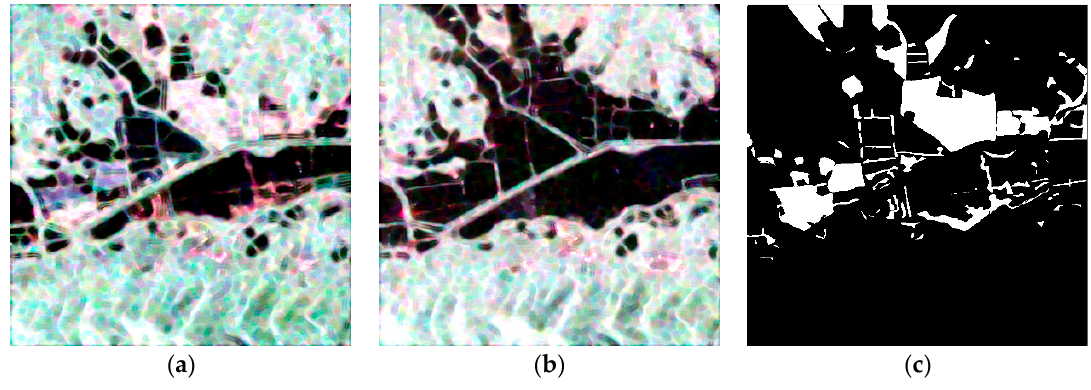
Figure 5. The Pauli-RGB images of YanDong Lake after preprocessing on ( a ) 25 June 2015; and ( b ) 6 July 2016. ( c ) Ground reference.